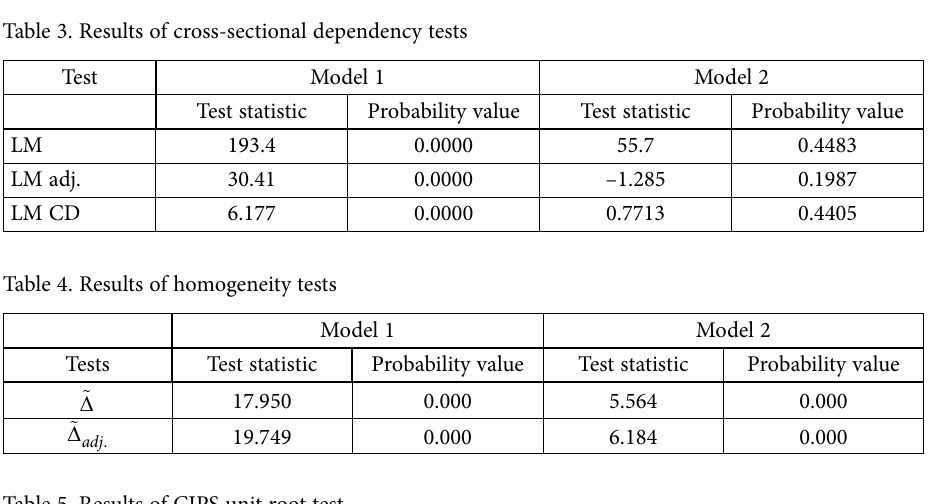
Table 5. Results of CIPS unit root